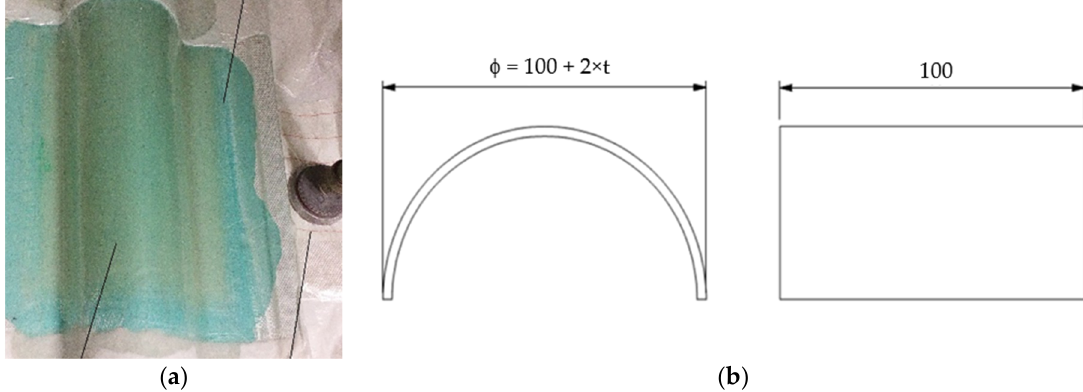
Figure 1. ( a ) Manufacturing process; ( b ) geometry and dimensions of the specimens in mm (t = thickness showed in Table 1).